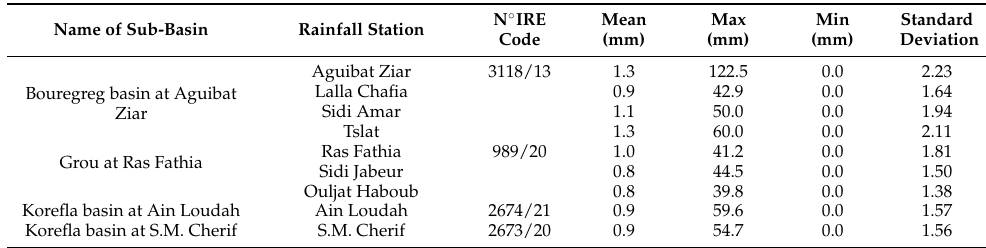
Table 2. Statistical characteristics of rainfall data by sub-basin during the period from 1 September 2016 to 31 August 2021.